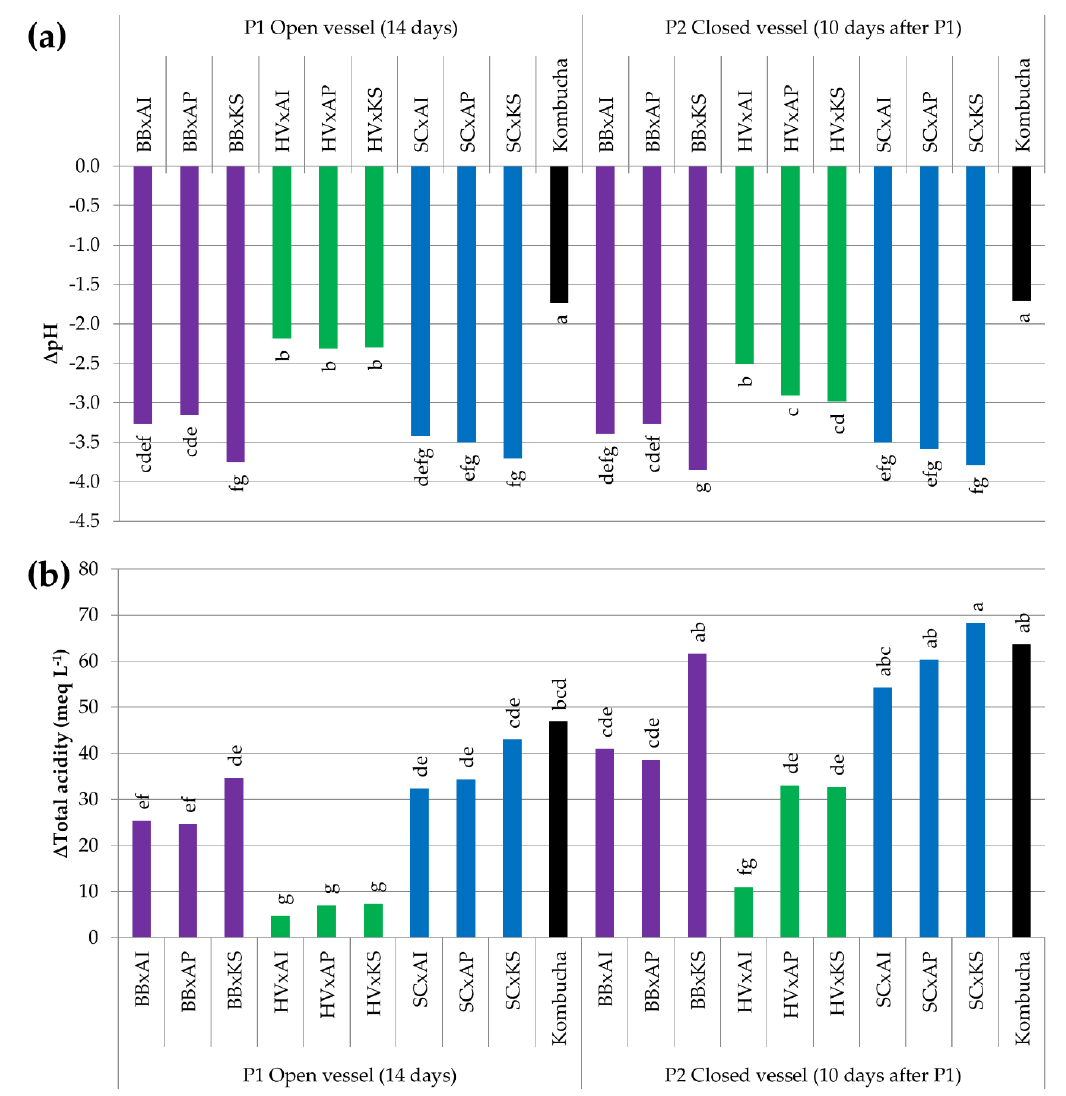
Figure 7. Difference in the ( a ) pH value (arbitrary unit) and ( b ) total acidity (meq L − 1 ) of samples between day 0 (after inoculation) and the end point (14 days for pure cultures, 14 days in an open vessel for P1, and 10 days in a closed vessel following P1 for P2). ANOVA was performed with α = 0.05 and n = 3. Common letters imply non-significant differences between means. Colors reflect the yeast species in the coculture. BB = Brettanomyces bruxellensis (purple), HV = Hanseniaspora valbyensis (green), SC = Saccharomyces cerevisiae (blue), AI = Acetobacter indonesiensis , AP = Acetobacter papayae , KS = Komagataeibacter saccharivorans , and “x” = a coculture.